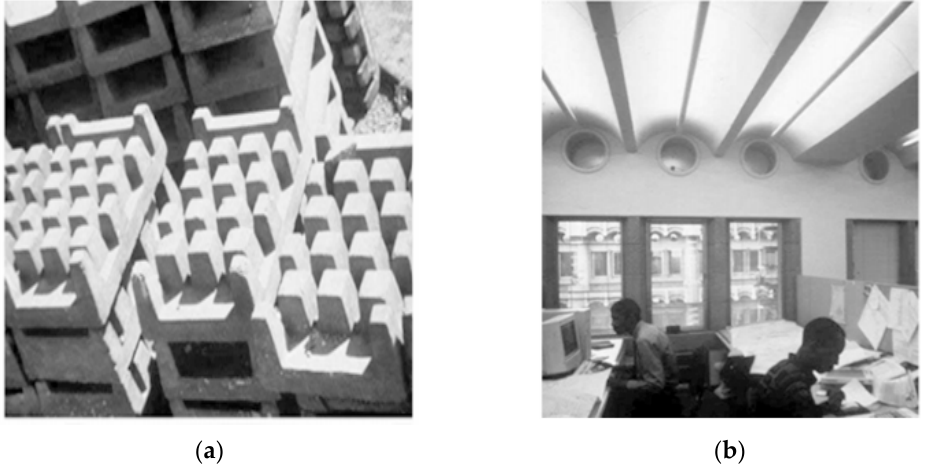
Figure 10. ( a ) Ecological concrete ventilated floor slabs and ( b ) vaulted ceilings.